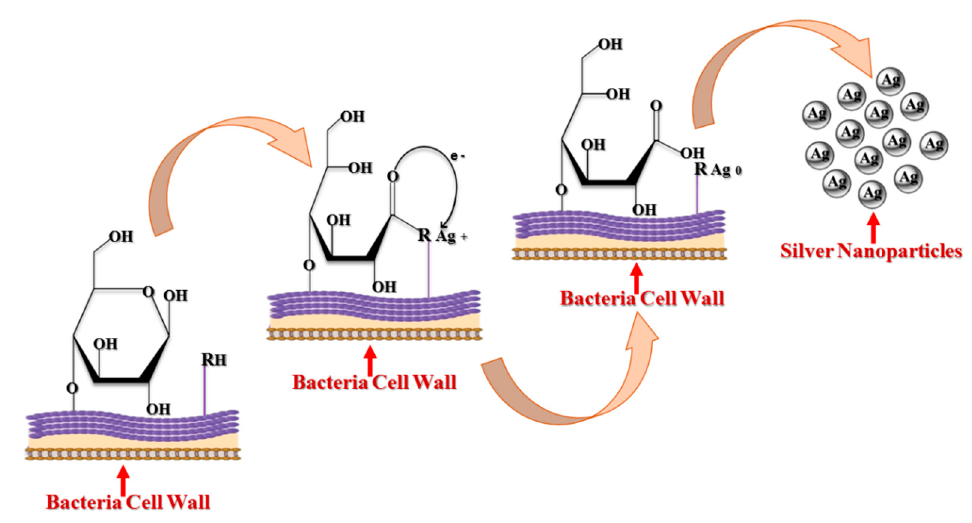
Figure 3. Intracellular non-enzymatic bacterial synthesis of AgNPs (modified from [57]).